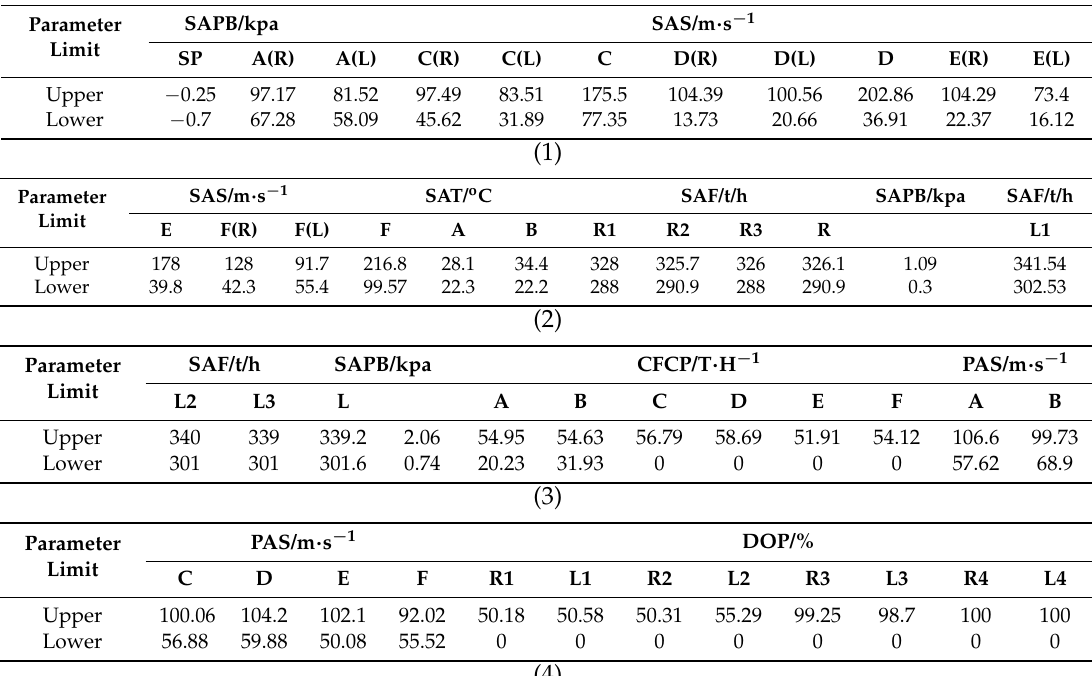
Table 4. (1)–(4) Optimization range of each tunable